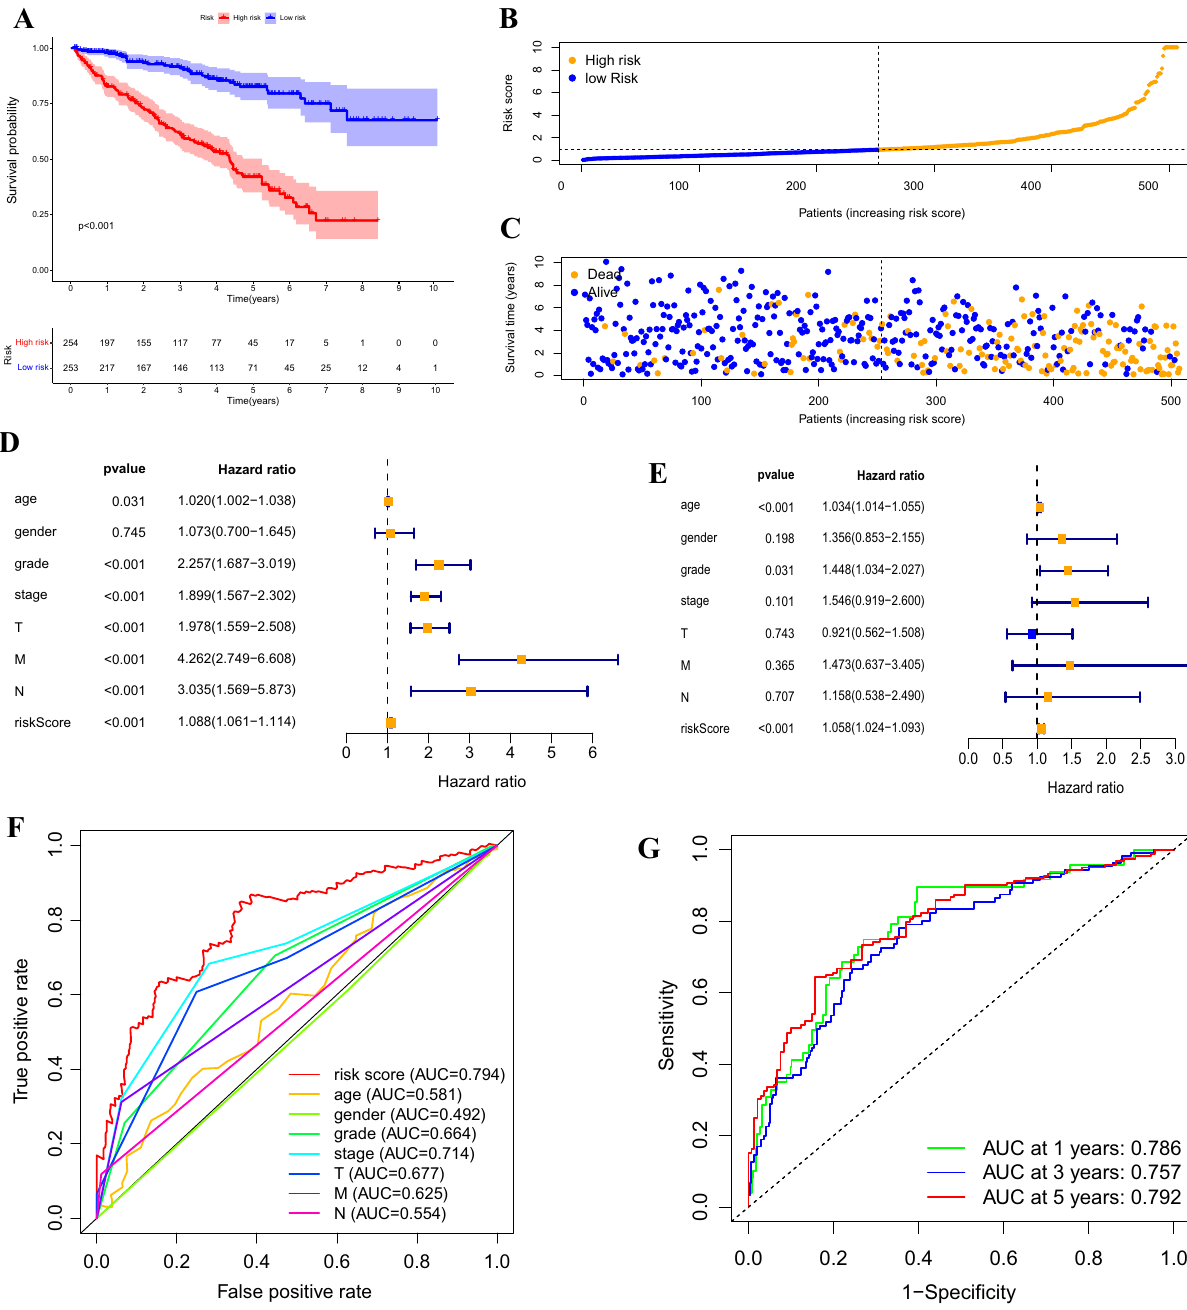
Correlation between the predictive signature and prognosis of patients with ccRCC . Risk scores were calculated for all patients, who were then divided into high-risk (n = 254) and low-risk (n = 253) groups based on the median risk score. According to the description of Kaplan–Meier survival curve, the overall survival was significantly lower in the high-risk group than that in the low-risk group (Fig. 3A, p < 0.001). The